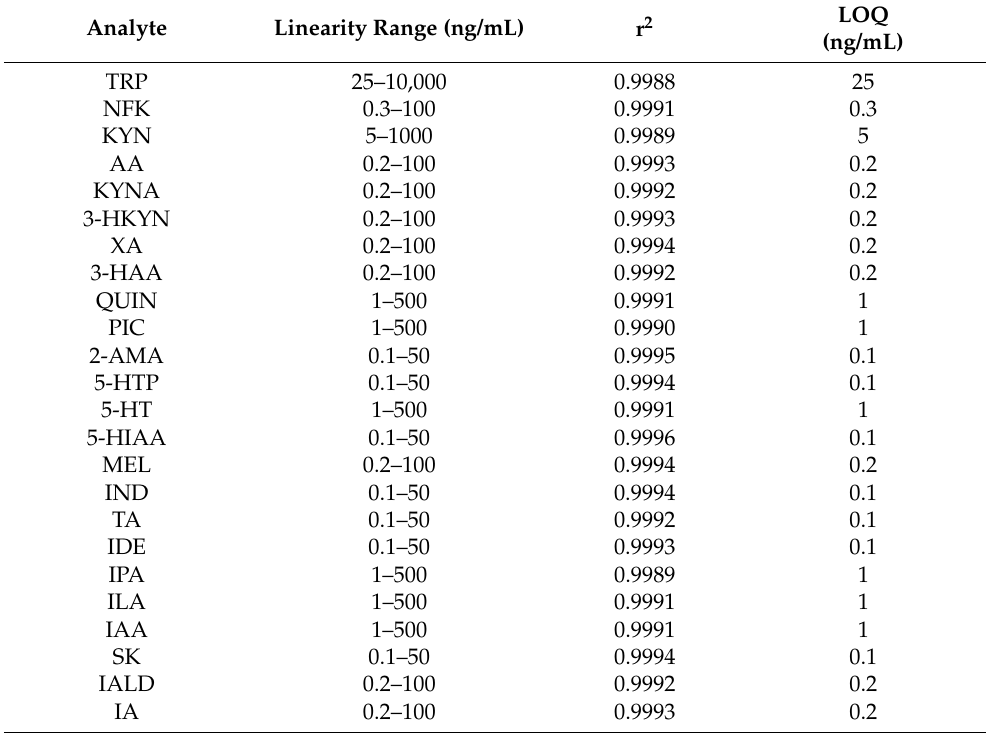
Table 3. Linearity and sensitivity